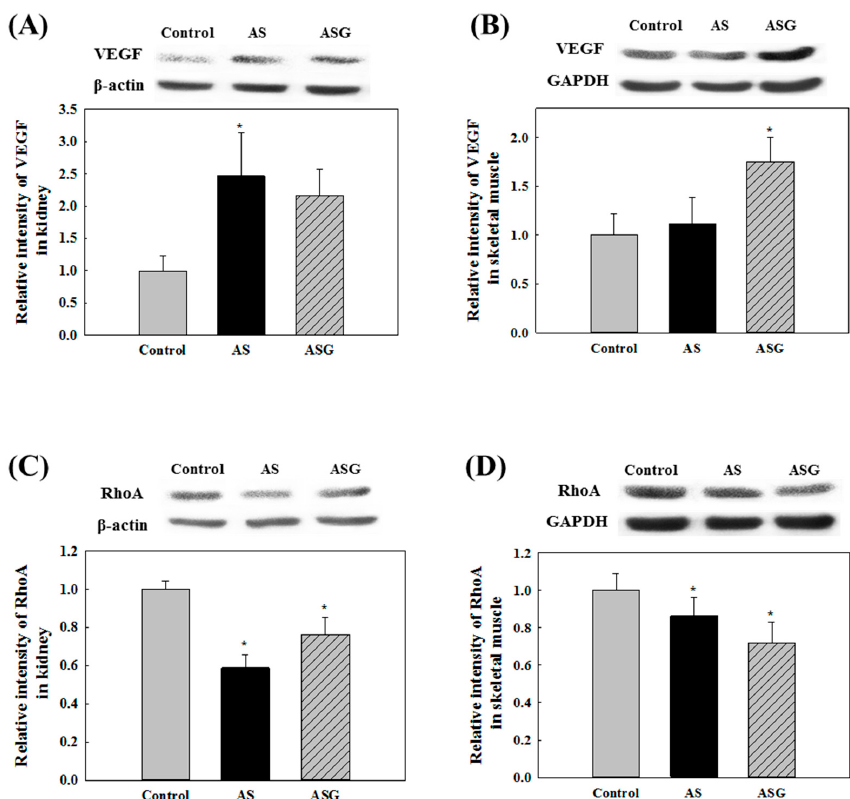
Figure 3. Expression levels of VEGF and RhoA in the rats fed the diet of AS and ASG for 6 weeks. The VEGF expression in kidney ( A ) and skeletal muscle ( B ); The RhoA expression in kidney ( C ) and skeletal muscle ( D ). Values are expressed as mean ± SD ( n = 8). * p < 0.05, compared with control (Tukey’s test).